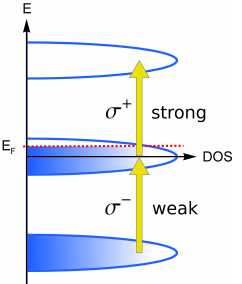
Figure 11: Tuning the relative pumping strength with doping. In a system with a positive Fermi energy, the pumping with σ + -polarized radiation is more eflcient, since transitions induced by σ − light are strongly suppressed by Pauli